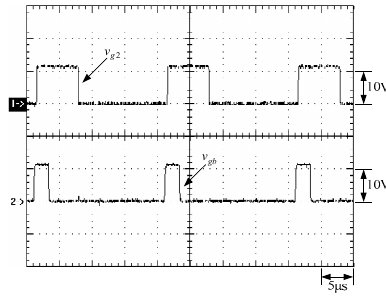
Figure 15. Waveforms pertaining to S 2 and S b evenly at the minimum load: (1) v g 2 ; and (2) v gb .